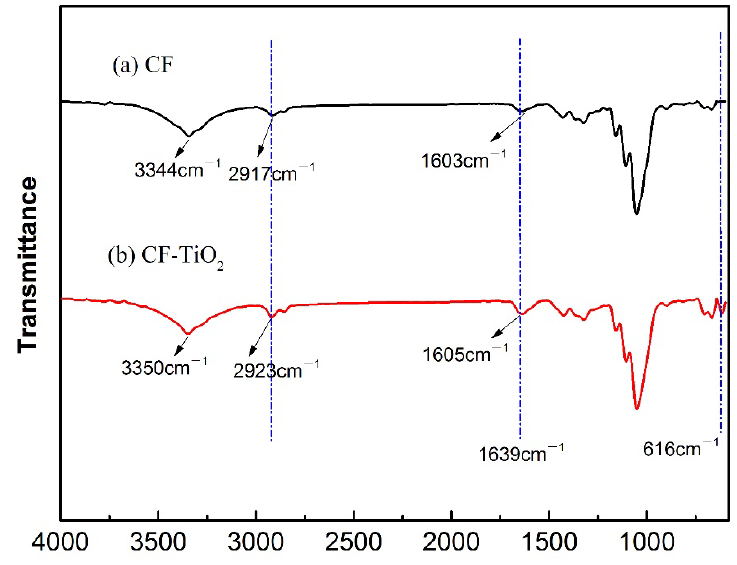
Figure 4. FTIR curves: ( a ) CF; ( b ) CF− TiO 2 .